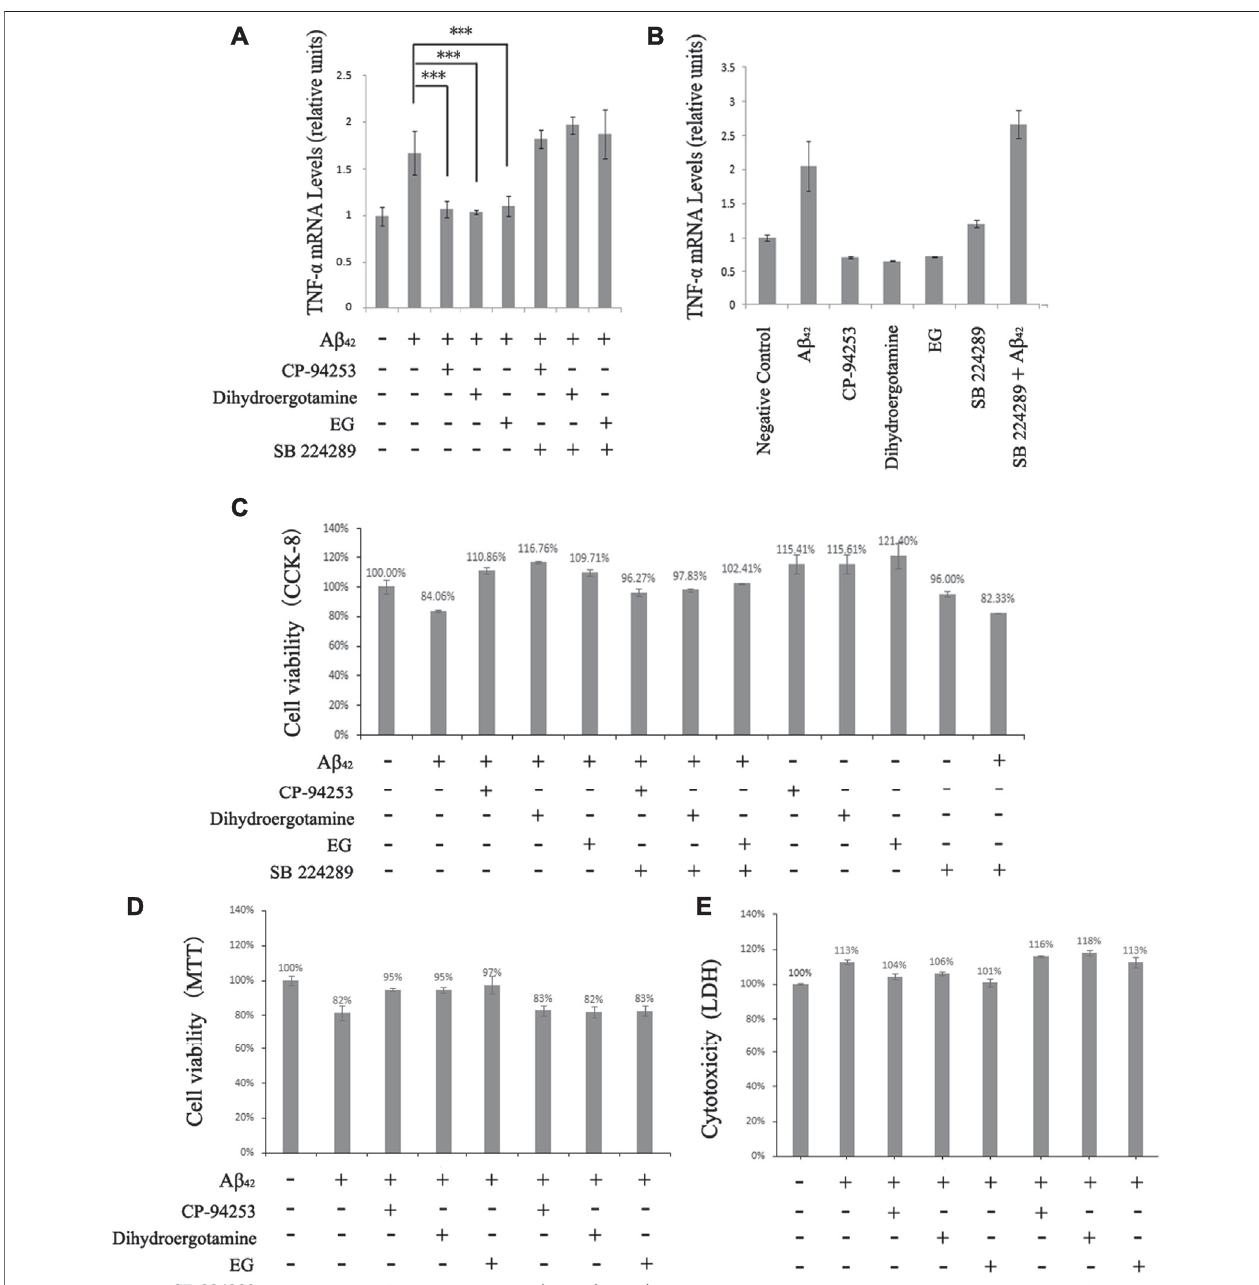
FIGURE7| CelldeathpromotingeffectofA β 42 in5-HT 1B over-expressedstablePC12cellseliminatedbyTNF- α signalingreductionvia5-HT 1B pathwayactivation. A .TNF- α mRNAlevelinducedbyA β 42 (20 μ M).5-HT 1B agonists(CP-94253anddihydroergotamine)andEGaddedasindicatedat10 − 7 M.Tocon fi rm5-HT 1B mediated pathway role,the5-HT 1B wasblockedbyits selectiveantagonistSB224289 (10 − 7 M),andtheTNF- α mRNAlevelwasmeasured inthepresenceofdihydroergotamine, CP-94253 and EG.The mean values ( ± S.D.) ofthree independent experiments are shown.Asterisksindicate statistical signi fi cance (*** p << 0.001). B .Compounds shown in A were separately tested for their effects on inducing TNF- α expression in 5-HT 1B over-expressed, stable PC12 cells. C , D , E . 5-HT 1B over-expressed stable PC12cellswerepre-treatedwiththeCP-94253,dihydroergotamine,andEGat10 − 7 Mfor18h,thensubjectedtoA β 42 (20 μ M)ornot,for24 h,followedbyCCK-8,MTT Kit viability assay and LDH for cytotoxicity. SB 224289 was applied 20 min before CP-94253, dihydroergotamine, and EG when necessary.